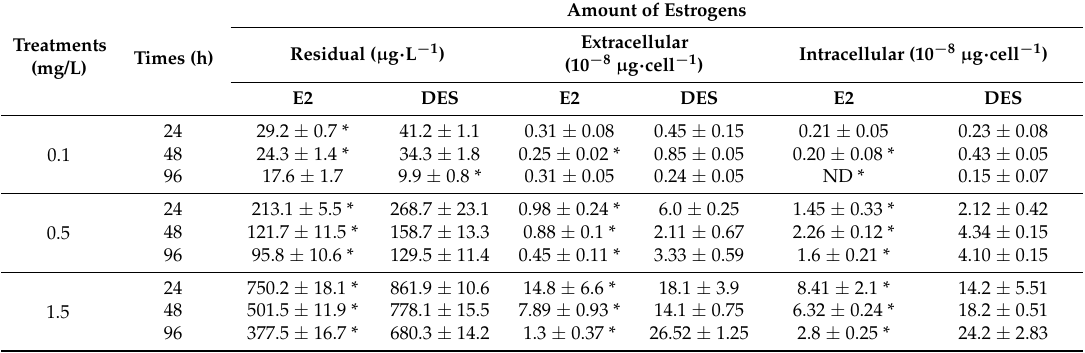
Table 2. Residual, intracellular, and extracellular E2 and DES contents under single treatments.